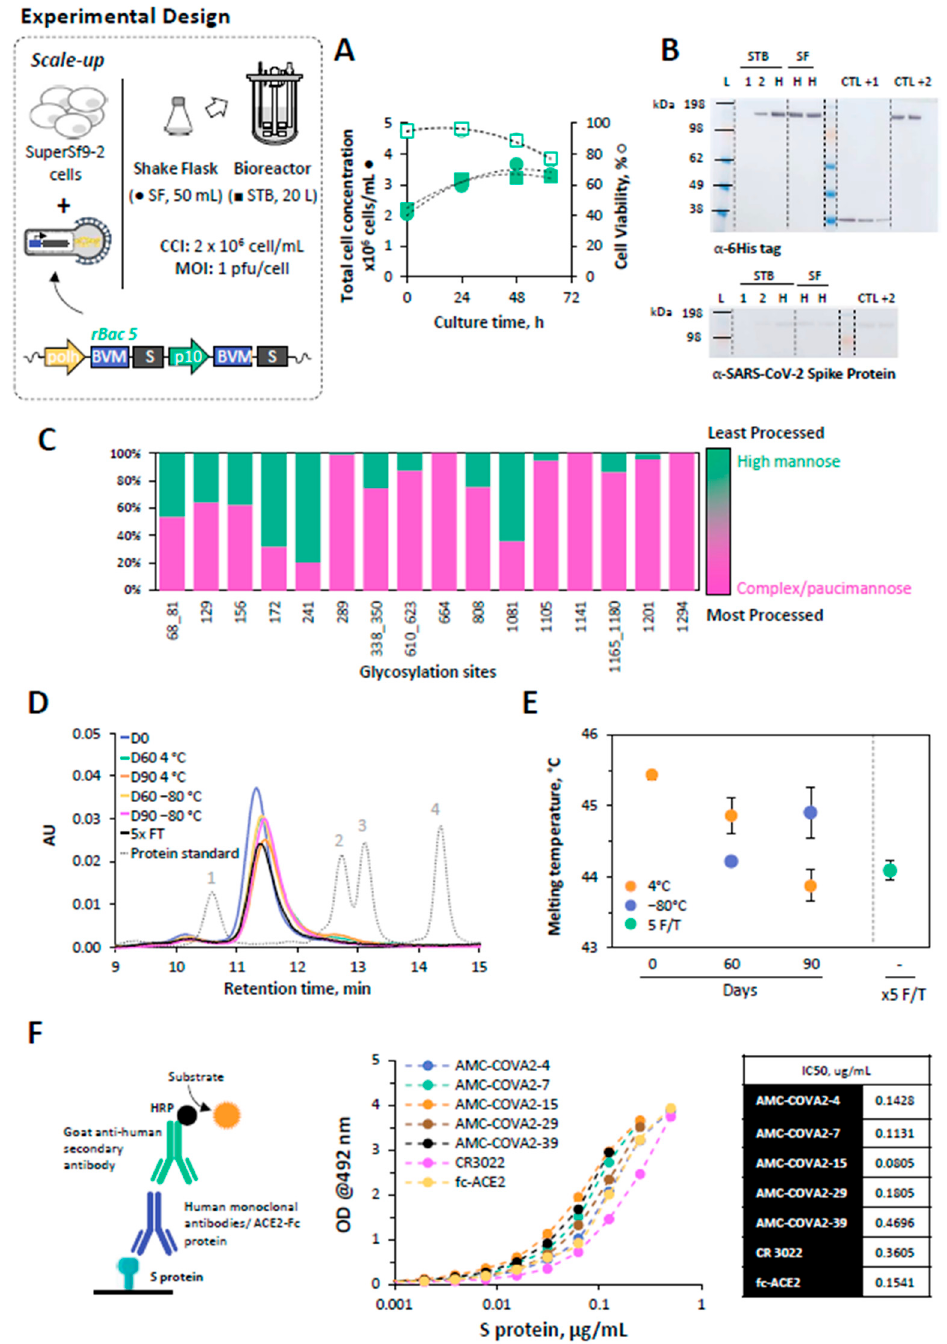
Figure 3. Production of SARS-CoV-2 spike (S) protein in a 20 L stirred-tank bioreactor (STB). ( A ) Cell growth kinetics upon infection. ( B ) Identification of S protein in supernatant samples collected at day 1, 2 and at time of harvest (H, 63 hpi) from STB and shake-flask (SF) cultures by Western blot; a mouse monoclonal 6-Histag antibody and a human monoclonal SARS-CoV-2 S antibody were used; positive controls were an in-house purified protein with a hexahistidine tag in the C-terminal at 0.2, 0.1 and 0.05 μ g (CTL + 1) and an in-house purified spike protein with a hexahistidine tag in the C-terminal at 1 and 0.5 ng (CTL + 2); Ladder (L) is SeeBlue™ Plus2 Pre-stained Protein Standard; the expected MW of S protein monomer is approximately 140 kDa; STB and SF denote stirred-tank bioreactor. SF denote samples from shake-flask control 1 and 2, respectively. ( C ) Site-specific glycan analysis of S protein by mass spectrometry; glycans were grouped in categories: high mannose gly- can series—M9 to M5; Man 9 GlcNAc 2 to Man 5 GlcNAc 2 (green), and complex/paucimannose glycans (pink). ( D ) HPLC-SEC analysis of S protein upon storage at different temperatures and upon ×5